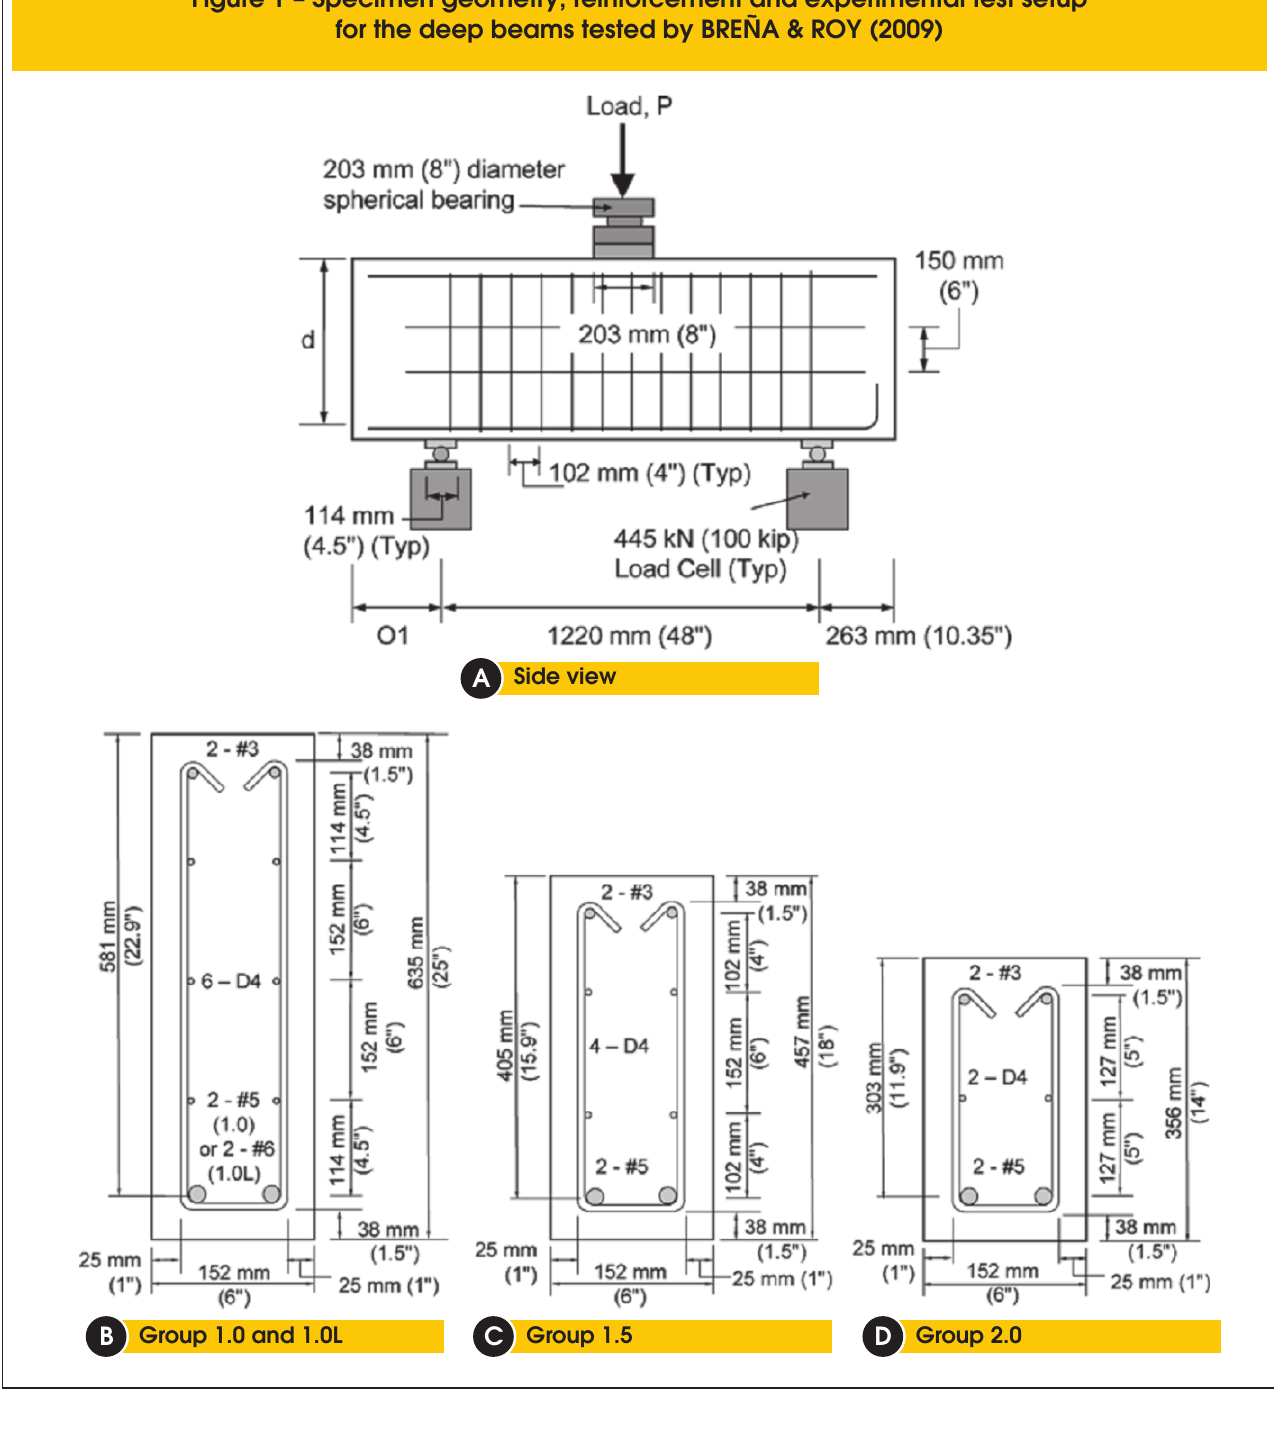
Figure 1 – Specimen geometry, reinforcement and experimental test